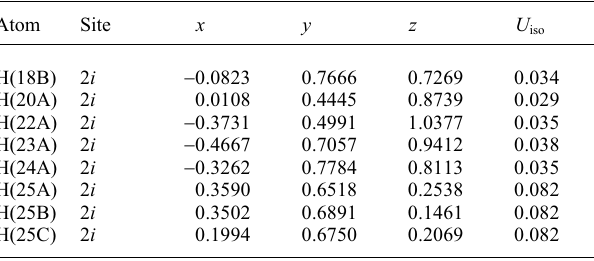
Table 3. Atomic coordinates and displacement parameters (in Å 2 )